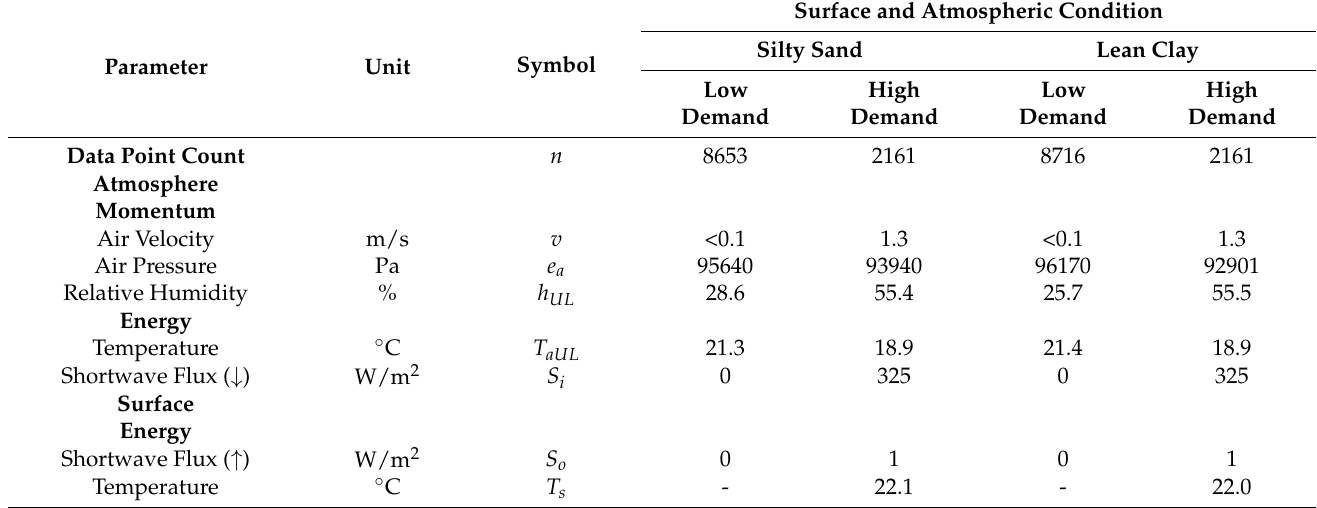
Table 3. Summary of measured atmospheric and surface